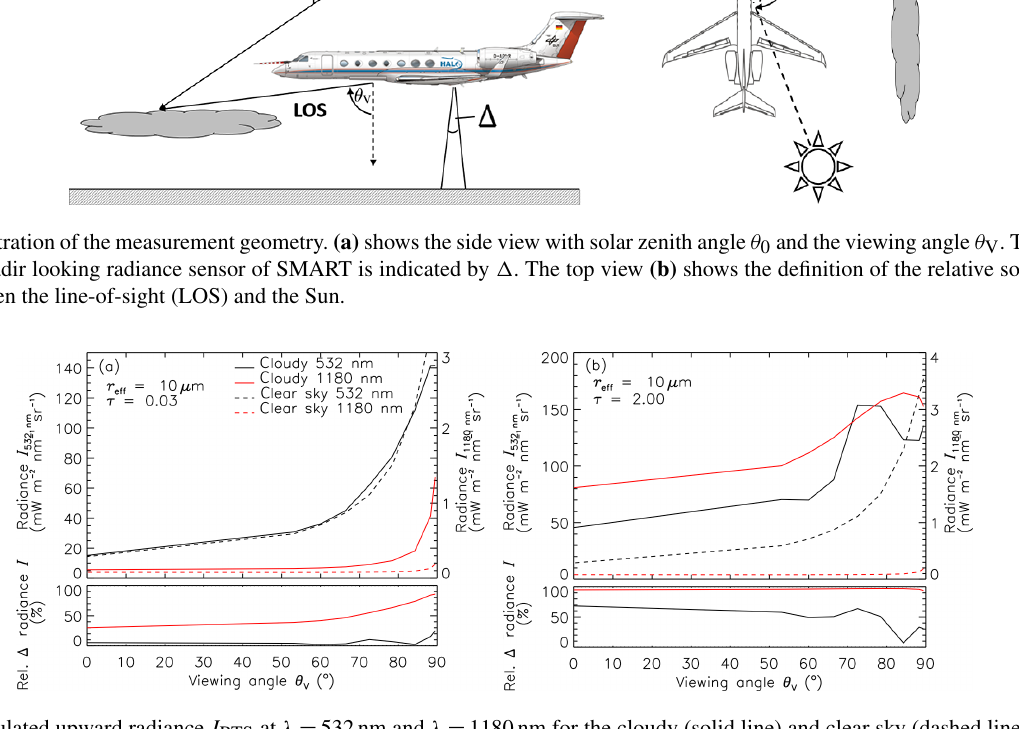
Figure 2. Simulated upward radiance I RTS at λ = 532nm and λ = 1180nm for the cloudy (solid line) and clear sky (dashed line) cases as a function of the viewing angle θ V . The left plot shows simulations for a SVC with τ = 0 . 03 (a) and the right plot presents the simulations for a thick cirrus with τ = 2 . 0 (b) . In the corresponding lower plots the relative difference between cloud and clear sky atmosphere with respect to the cloudy atmosphere is